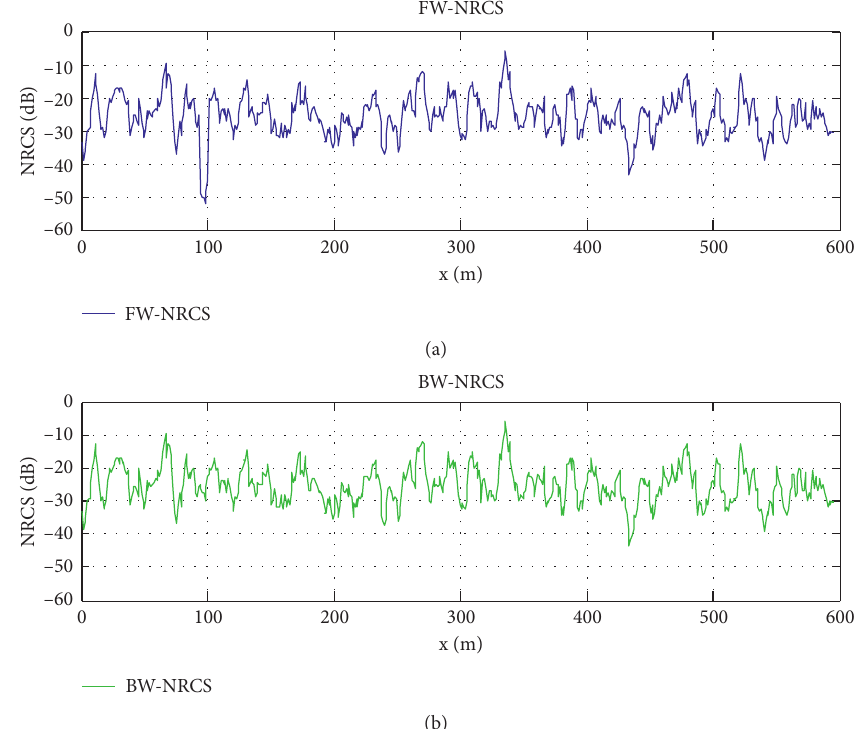
Figure 9: NRCS comparison result of simulated freak waves and their background waves based on KA method.